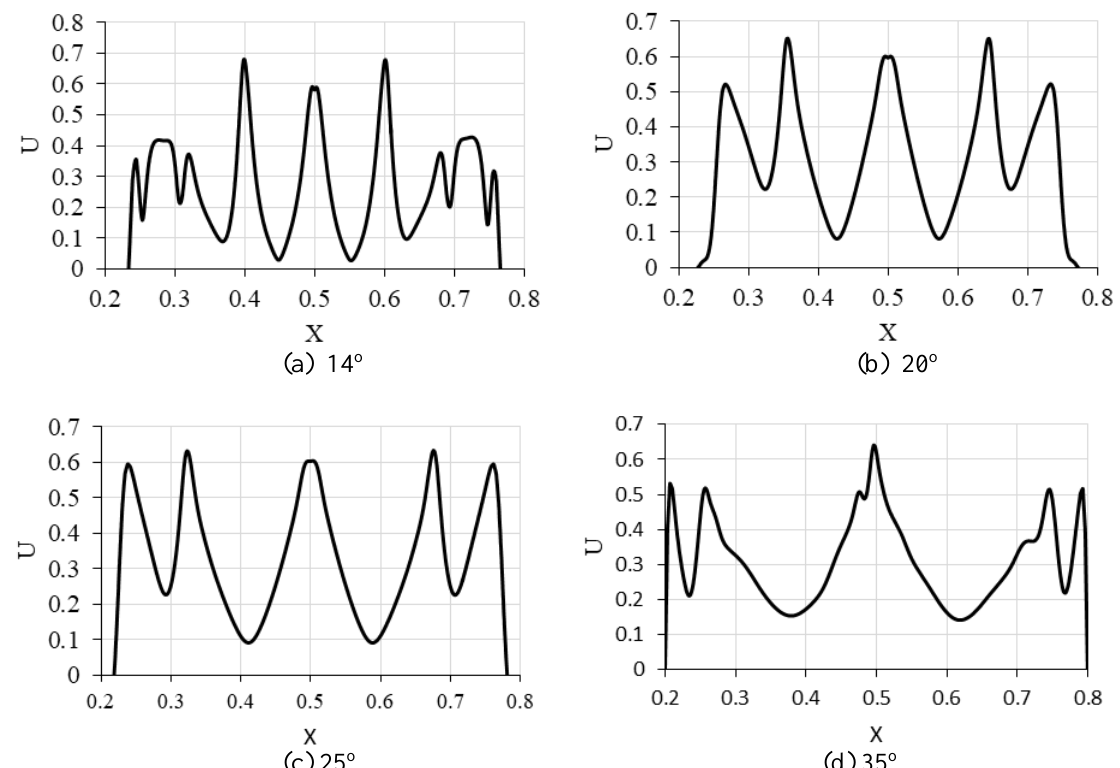
Fig. 5. Air velocity across midheight (Y= 0.5H) of different